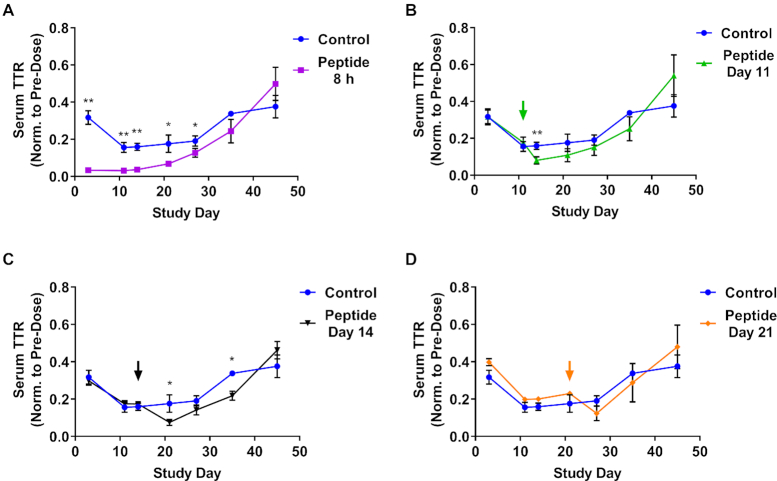
Chemically stabilized siRNA survives for weeks in acidic intracellular compartments. An Advanced ESC GalNAc–siRNA (siTTR-2) targeting Ttr was dosed SC at 0.5 mg/kg (all cohorts including the control group, which is shown in each graph as a comparison). GalNAc-INF7 endolytic peptide was dosed SC at 5 mg/kg in cohorts of mice at either 8 h (A) or days 11 (B), 14 (C) or 21 (D) post siRNA dose. Serum TTR protein levels were monitored through day 45. Data is represented as mean ± SD, for N = 3. Welch's independent t-test was utilized to compare the mean value between the control and peptide-treated groups at each timepoint to identify significant differences in target knockdown(*P ≤ 0.05, **P ≤ 0.01). Full results for the statistical analysis are included in the Supplemental Information.